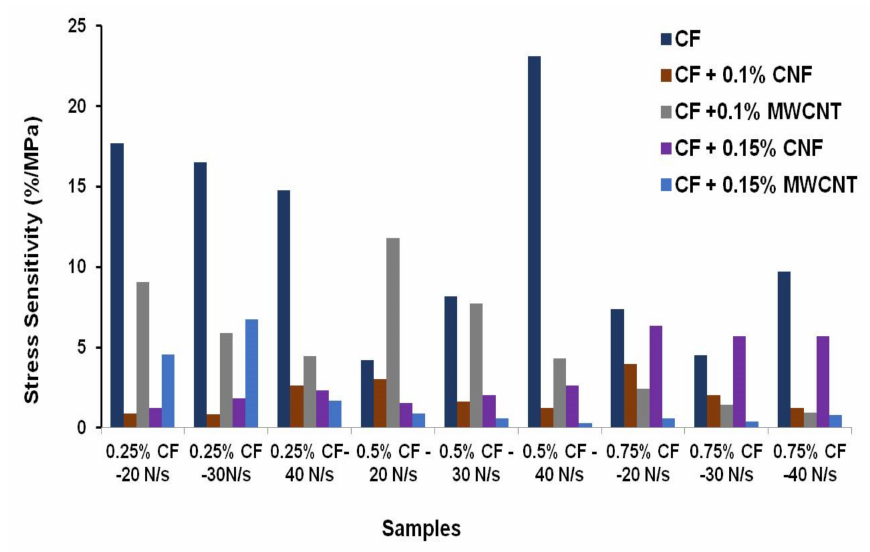
Figure 15. Stress sensitivity of various cement based